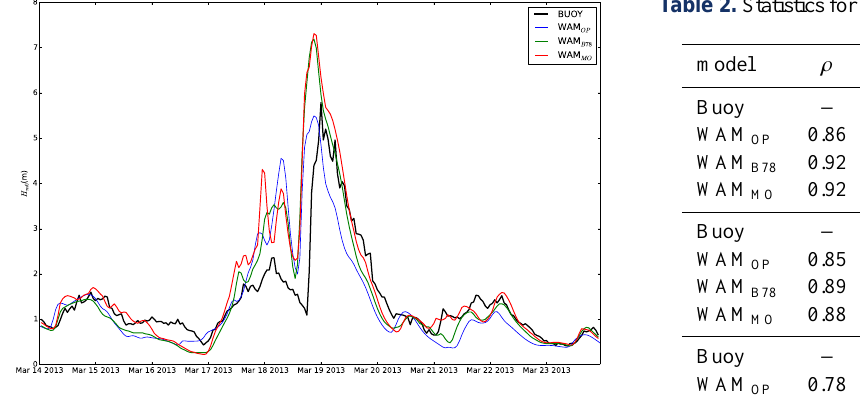
Figure 10. Test-case 3: comparison between forecast and buoy data at La Spezia buoy location.